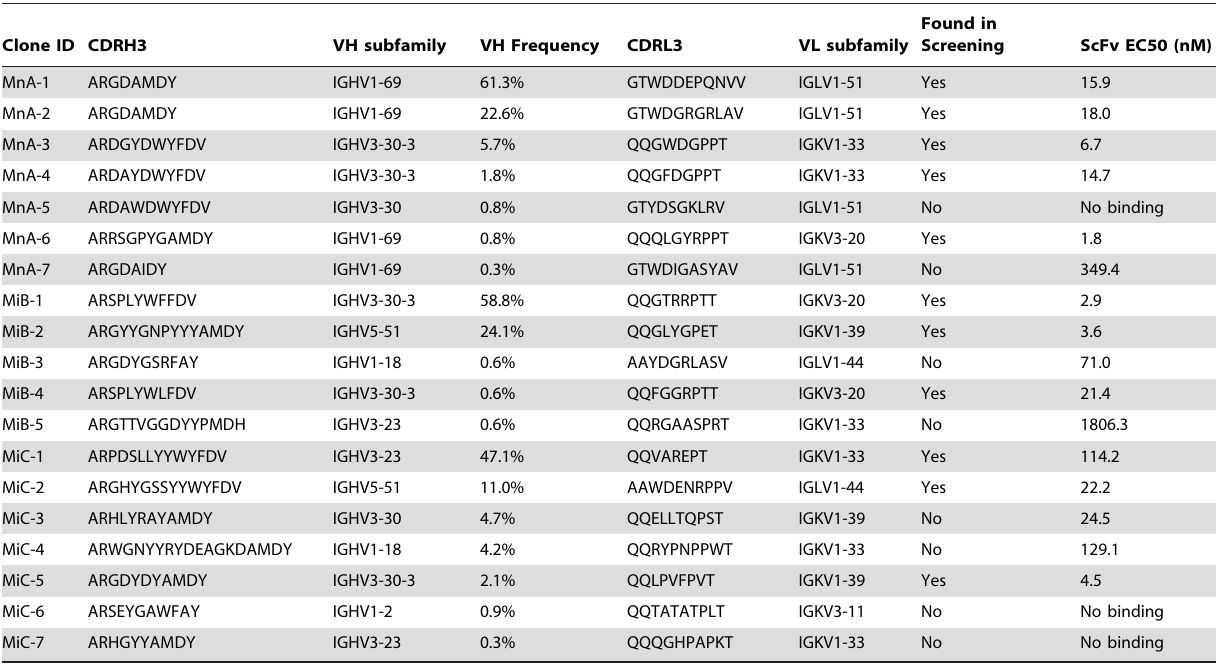
Table 2. Frequency and potency of binders derived from murine diversity.